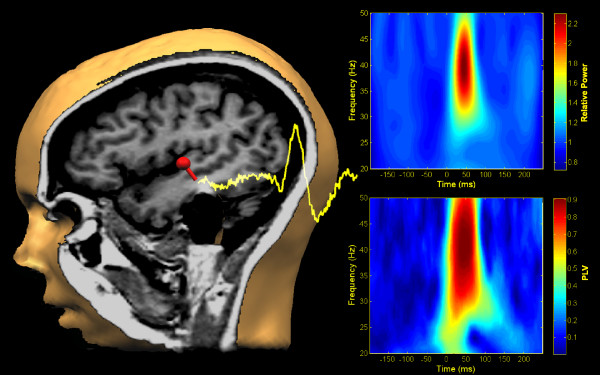
Source space projection and time-frequency analysis. Left hemisphere data from a single participant are illustrated. A single equivalent current dipole was fit to the sensor data and is shown overlaid onto the co-registered MRI scan for the same individual (left). The yellow waveform is the unfiltered, source-space projected, phase-locked average waveform resulting from that dipole (the M50, M100 and M200 responses can be seen in the waveform). In the upper right panel, a time-frequency plot illustrates the transient gamma-band response in terms of power relative to the pre-stimulus baseline. The lower right panel illustrates the PLF for the same data. Note the peak power and PLF centered around 50 ms post-stimulus at 40 Hz.